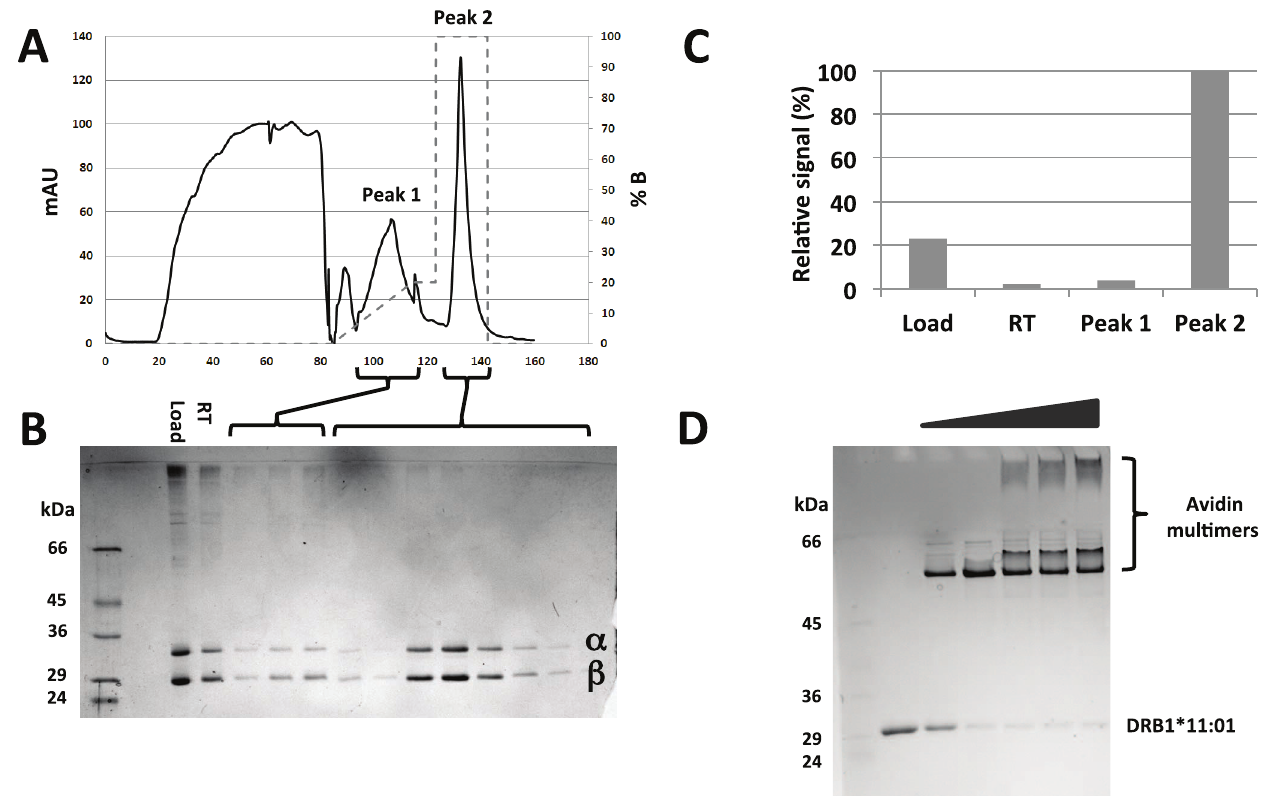
Figure 1. Purification of H 6 -tagged MHC class II complexes. A) Preparative purification of DRB1*04:01 refolded with Hep C-NS3 218–235(H6) (YAAQGYKVLVLNPSVAATHHHHHH) on IMAC column, a shallow gradient of 20% 8 M Urea, 25 mM Tris, pH8, and 1 M NaCl (buffer B) elutes peak 1 whereas peak 2 elutes by raising the concentration of buffer B to 100%. B) SDS-PAGE analysis of eluted fractions, the a chain travels as the upper band. C) Functional LOCI assay on load, run through, and peak fractions. Notice the absence of peptide-loaded MHC class II molecules in the run through (RT) and in peak 1. D) Assessing the level of biotinylation of a DRB1*11:01 chain by incubation with increasing amounts of avidin followed by SDS-PAGE